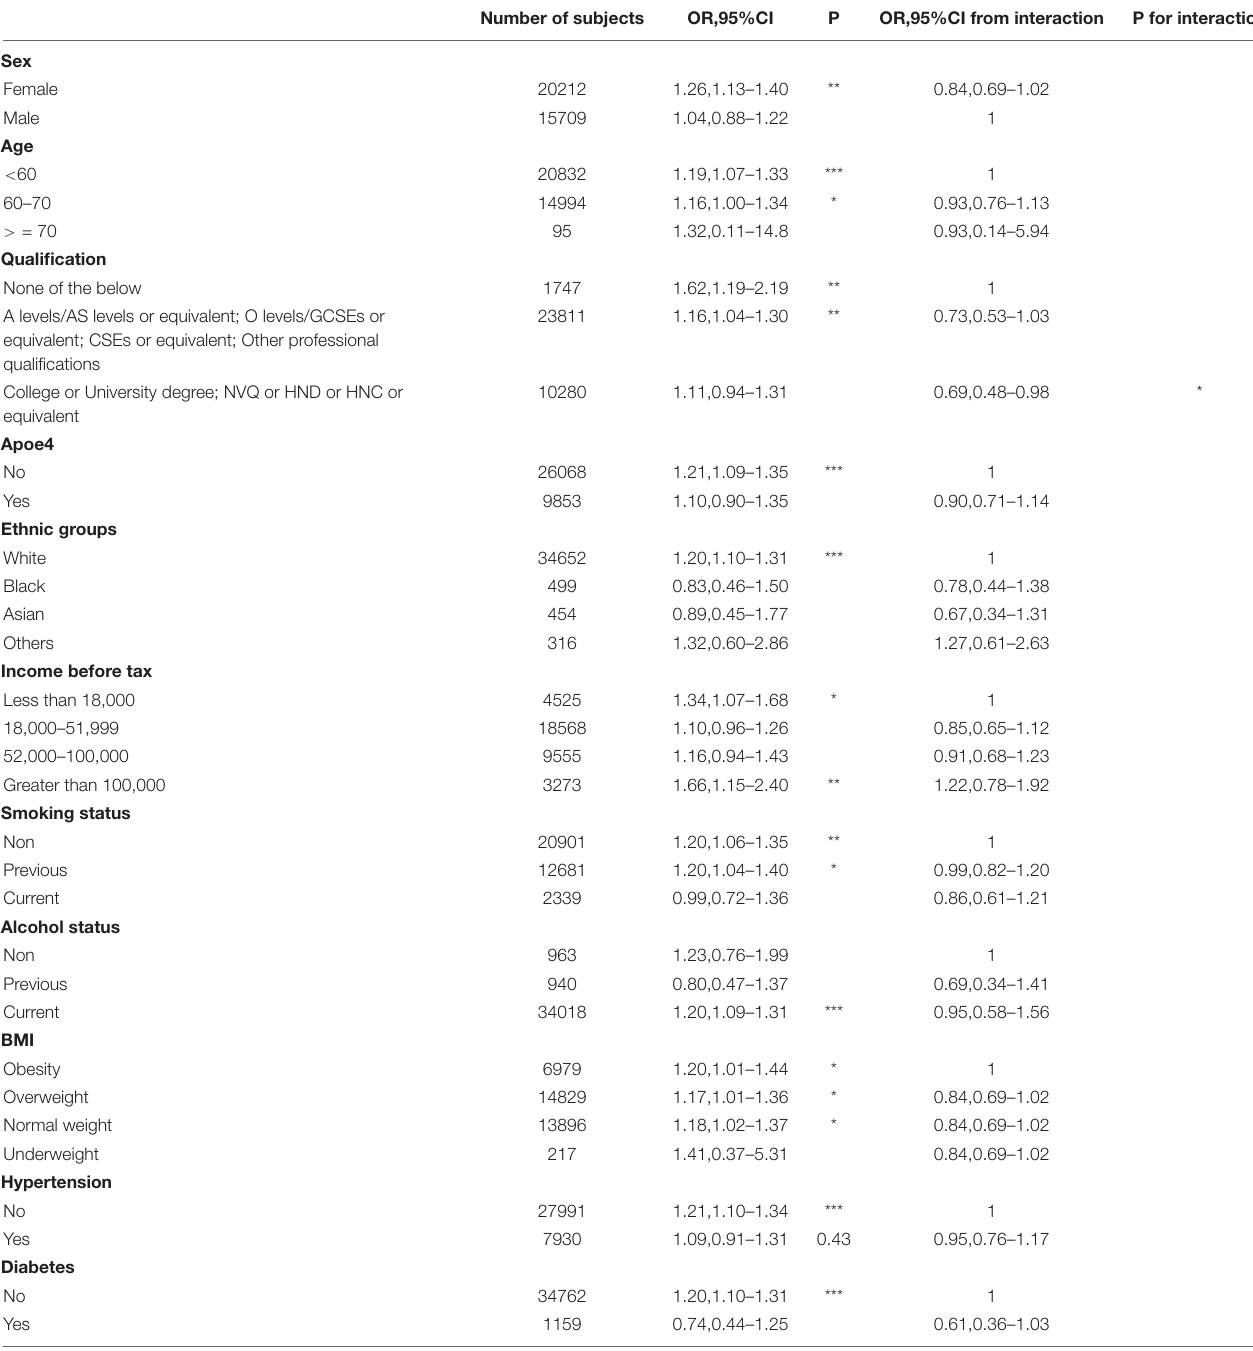
TABLE 3 | Long-term/recurrent use of antibiotics and risk of cognitive impairment: Subgroup analysis. Number of subjects